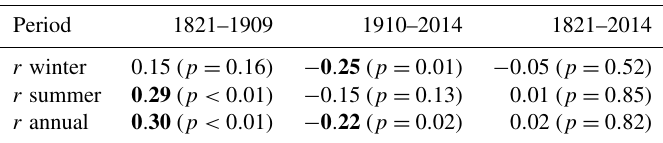
Figure 8. Monthly averaged 2m temperature from a grid point on Renland (blue curve) plotted together with the forward-diffused δ 18 O from the RECAP ice core (red curve) and A6 snow pit core (green curve). Table 5. Correlation coefficients between the δ 18 O stack and NAO index. Both time series have been smoothed with a 5-year moving mean. Only the numbers in bold are statistically significant ( p < 0 .